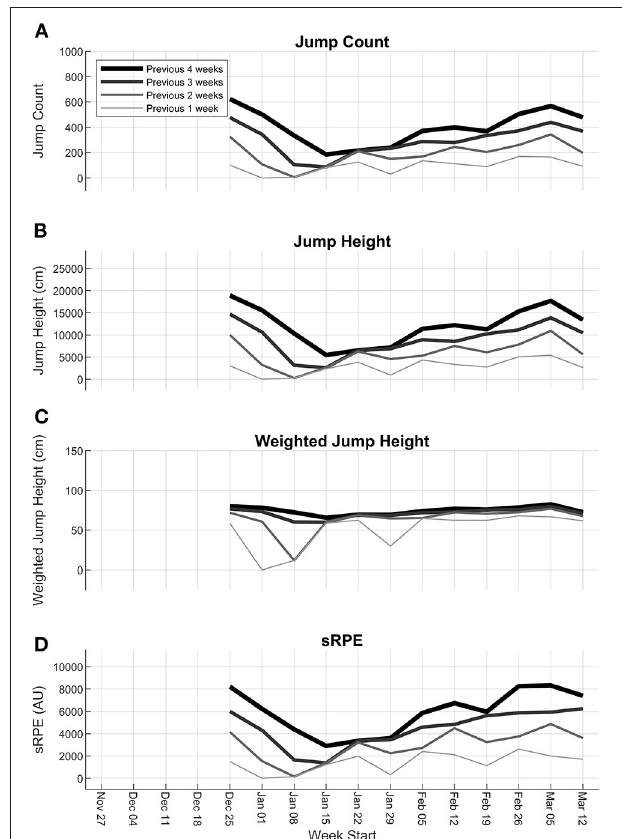
FIGURE 2 | Mean 1-, 2-, 3-, and 4-week workloads of uninjured participants throughout the season for (A) jump count, (B) jump height, (C) weighted jump height, and (D)